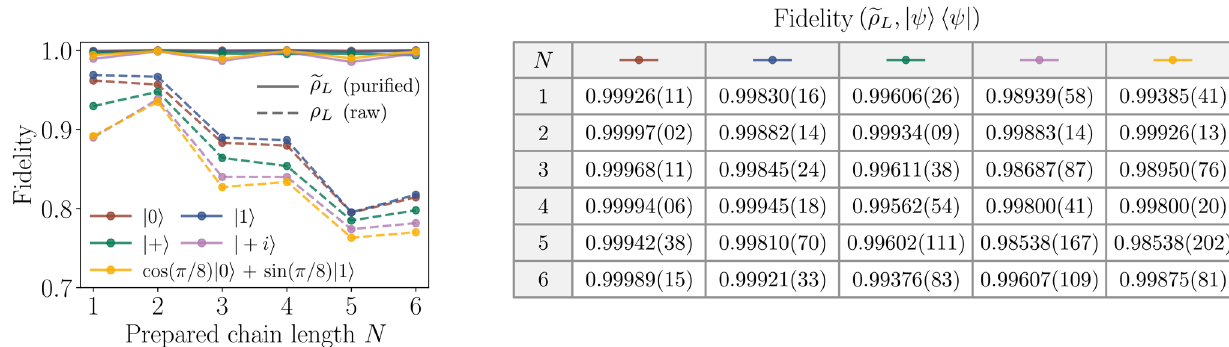
FIG. 8. Quantum teleportation fidelity as a function of the AKLT chain length N for an ensemble of target states. The AKLT chains are prepared using our measurement-assisted scheme and subsequently used as a quantum wire to teleport a chosen target pure state | ψ (cid:3) from the right chain edge to the left. The fidelity between the target and (tomographically reconstructed) received message is plotted both for the raw ( ρ L , markers with dashed lines) and the McWeeny purified ( (cid:9) ρ L , markers with solid lines) received message, with colors differentiating intended target states. The fidelities between the target and purified received message are additionally tabulated in the right-hand panel, with digits in parentheses corresponding to 95% confidence intervals computed via 50 bootstrap numerical experiments, using 10 5 shots per